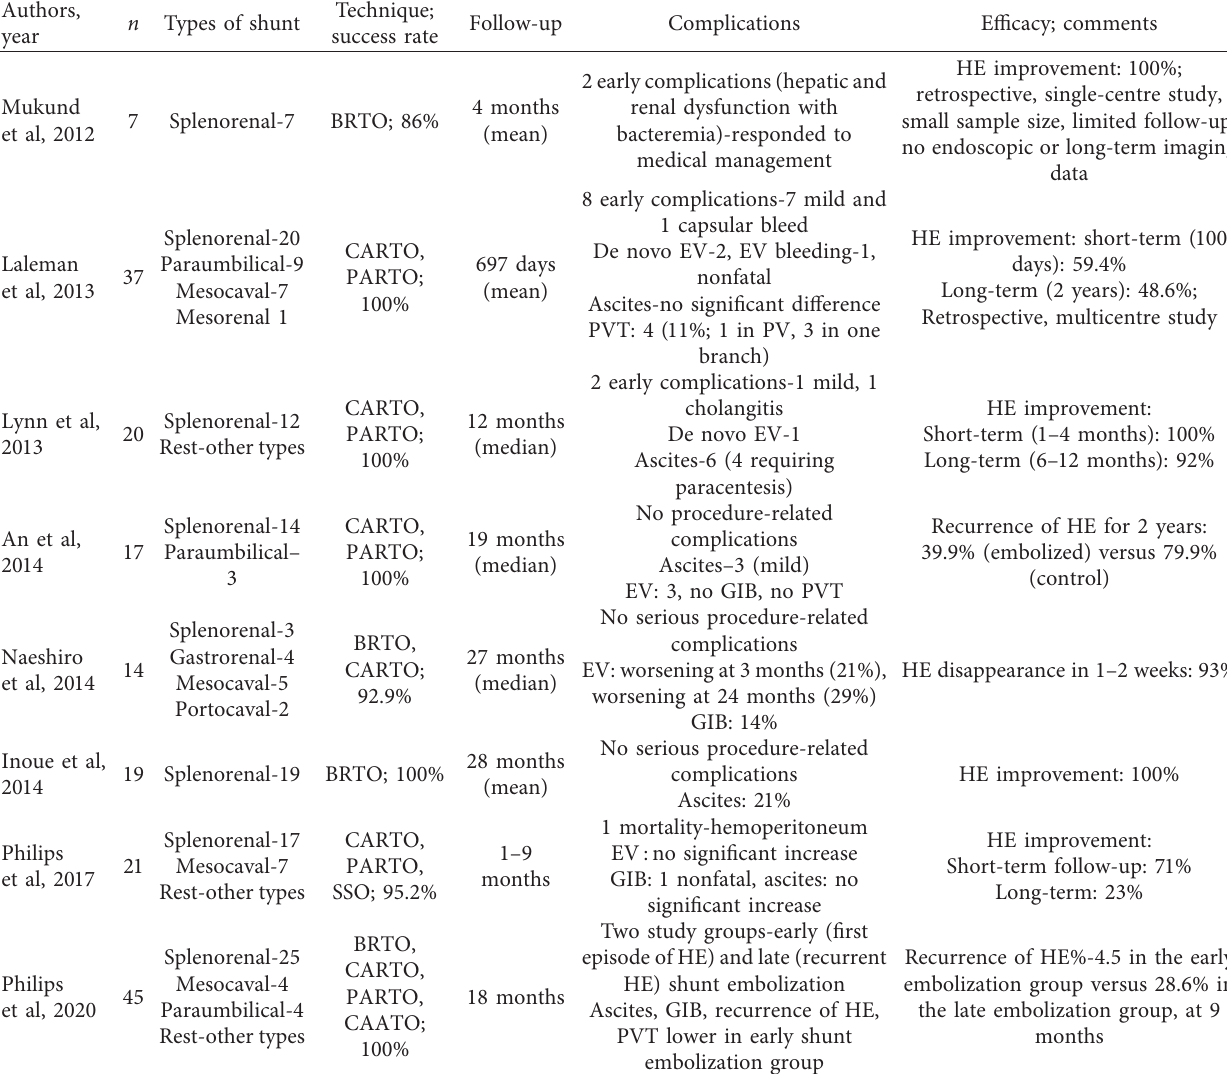
Table 1: Overview of recent studies on efficacy and safety of portosystemic shunt embolization for recurrent hepatic